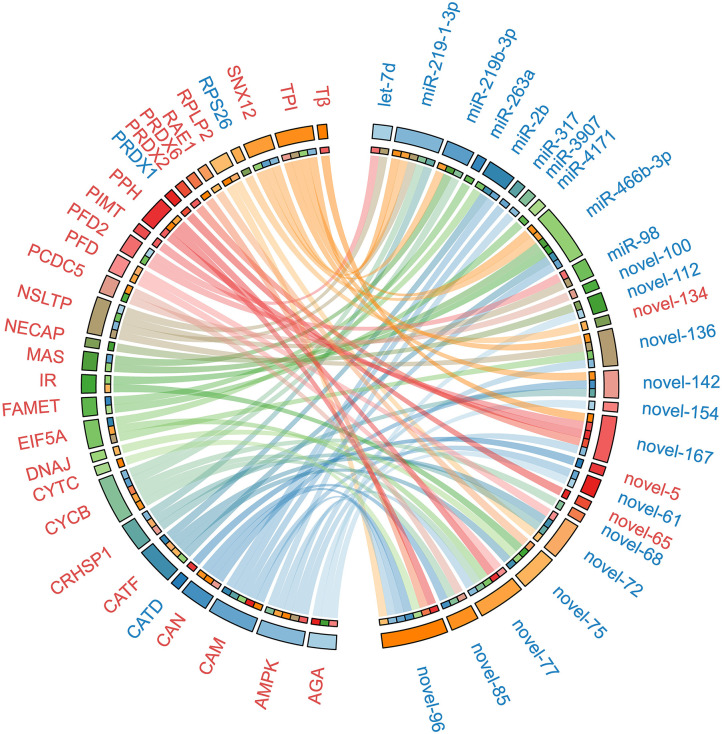
The miRNA-protein regulatory network constructed on the basis of in silico miRNA target prediction and inverse correlation of protein and miRNAs expression after ESA. Upregulated miRNAs and proteins are represented in red, and downregulated miRNAs and proteins are represented in blue. The abbreviations in the figure: RPLP2, 60S acidic ribosomal protein P2; NECAP, Adaptin ear-binding coat-associated protein 2; AMPK, AMP-activated protein kinase alpha subunit; AGA, Aspartylglucosaminidase; CRHSP1, Calcium-regulated heat stable protein 1; CAM, Calmodulin; CAN, Calnexin; CATD, Cathepsin D; CATF, Cathepsin F; CATF, Cathepsin F; CYCB, Cyclin B; CYTC, Cytochrome c; DNAJ, DnaJ homolog subfamily B member 9 precursor; EIF5A, Eukaryotic translation initiation factor 5A; FAMET, Farnesoic acid O-methyltransferase; IR, Insulin receptor; MAS, Masquerade-like protein; NSLTP, Non-specific lipid-transfer protein; PRDX1, Peroxiredoxin 1; PRDX2, Peroxiredoxin 2; PRDX6, Peroxiredoxin 6; PPH, Phosphopyruvate hydratase; PFD, Prefoldin; PFD2, Prefoldin subunit 2; PCDC5, Program cell death 5-like; PIMT, Protein-L-isoaspartate O-methyltransferase; RAE1, RAE1 RNA export 1 homolog; RPS26, Ribosomal protein S26; SNX12, Sorting nexin-12; Tβ, Thymosin beta; TPI, Triosephosphate isomerase.